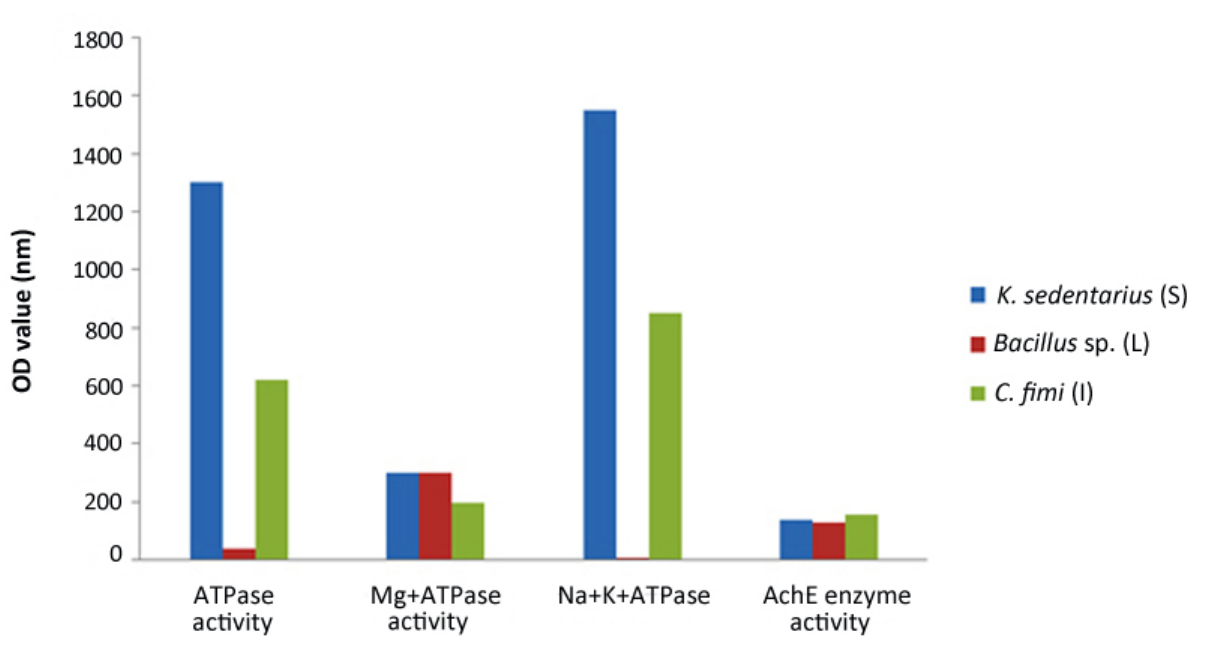
Figure 1. In vitro effect of toxin on mouse brain total ATPase, Mg + -ATPase, Na + -K + -ATPase and AchE enzyme